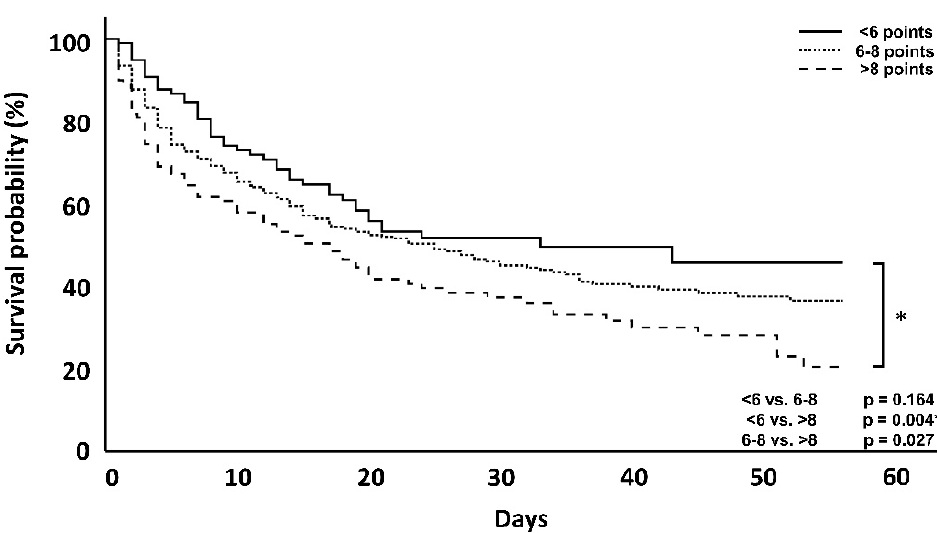
Figure 2. Kaplan–Meyer survival analysis at day 56 of the entire patient cohort. The p -values are via log-rank tests. * = Statistically significant using Bonferroni-adjusted alpha critical value = 0.017 for groups <6 vs. >8, but no other comparisons.